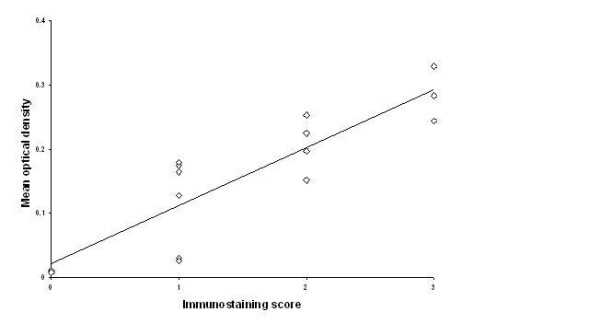
The viabililty of renal biopsy samples assessed by histopathological damage using immunostaining with CD10 antibody and by MTT reduction following incubation in preservative solution for 20 hours.